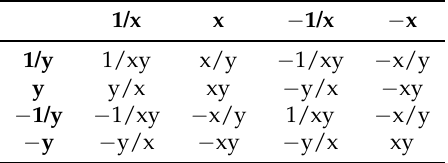
Table 3. All the possible combinations for multiplying and dividing two Posit numbers.